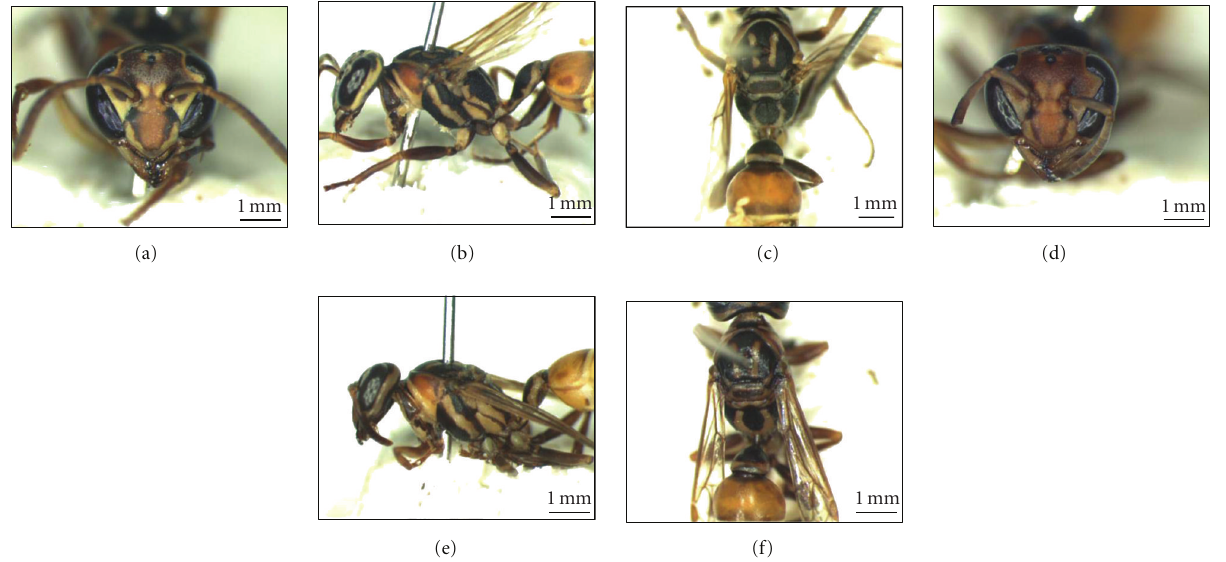
Figure 5: Color patterns: (a–c): view of worker; (d–f): view of